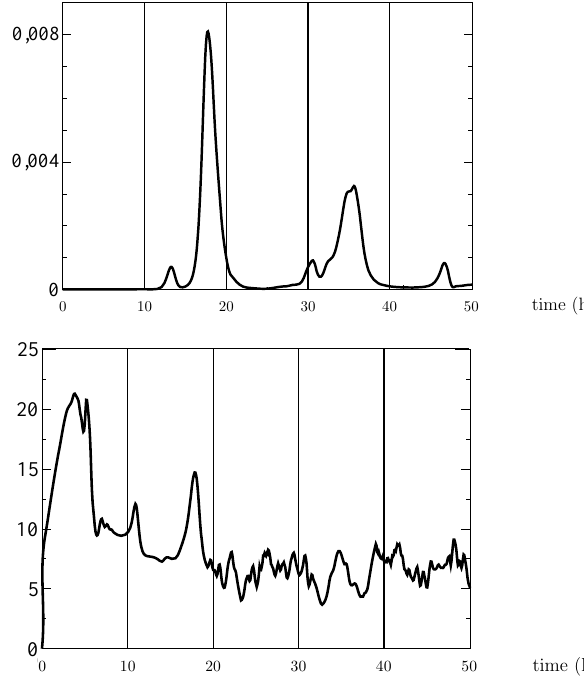
Fig. 4. Left figure shows E 3 which is highly intermittent in time. Right figure gives the kurtosis k 4 with values that show an intermit- tence in